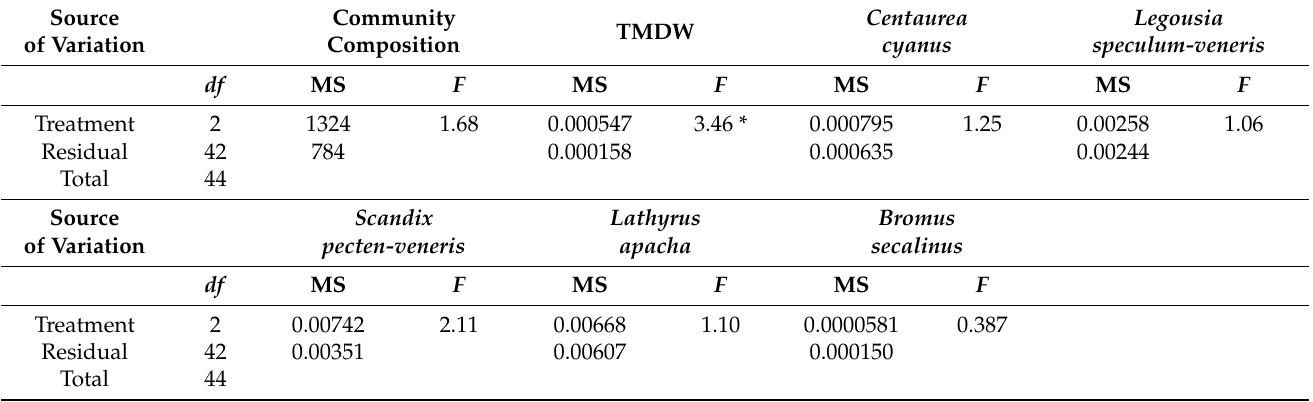
Table 5. Results of the PERMANOVA analyses on community composition with the mean dry weight of each species as an abundance measure, on the total mean dry weight per pot (TMDW), and on the mean dry weight of individuals per species per pot.